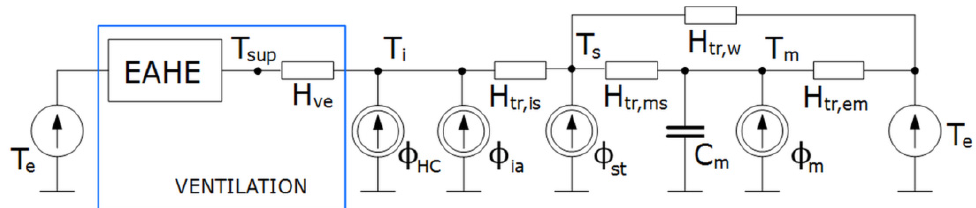
Figure 3. The circuit diagram of the 5R1C thermal network model of a building zone with an earth-to-air heat exchanger to supply ventilation earth-to-air heat exchanger to supply ventilation air.